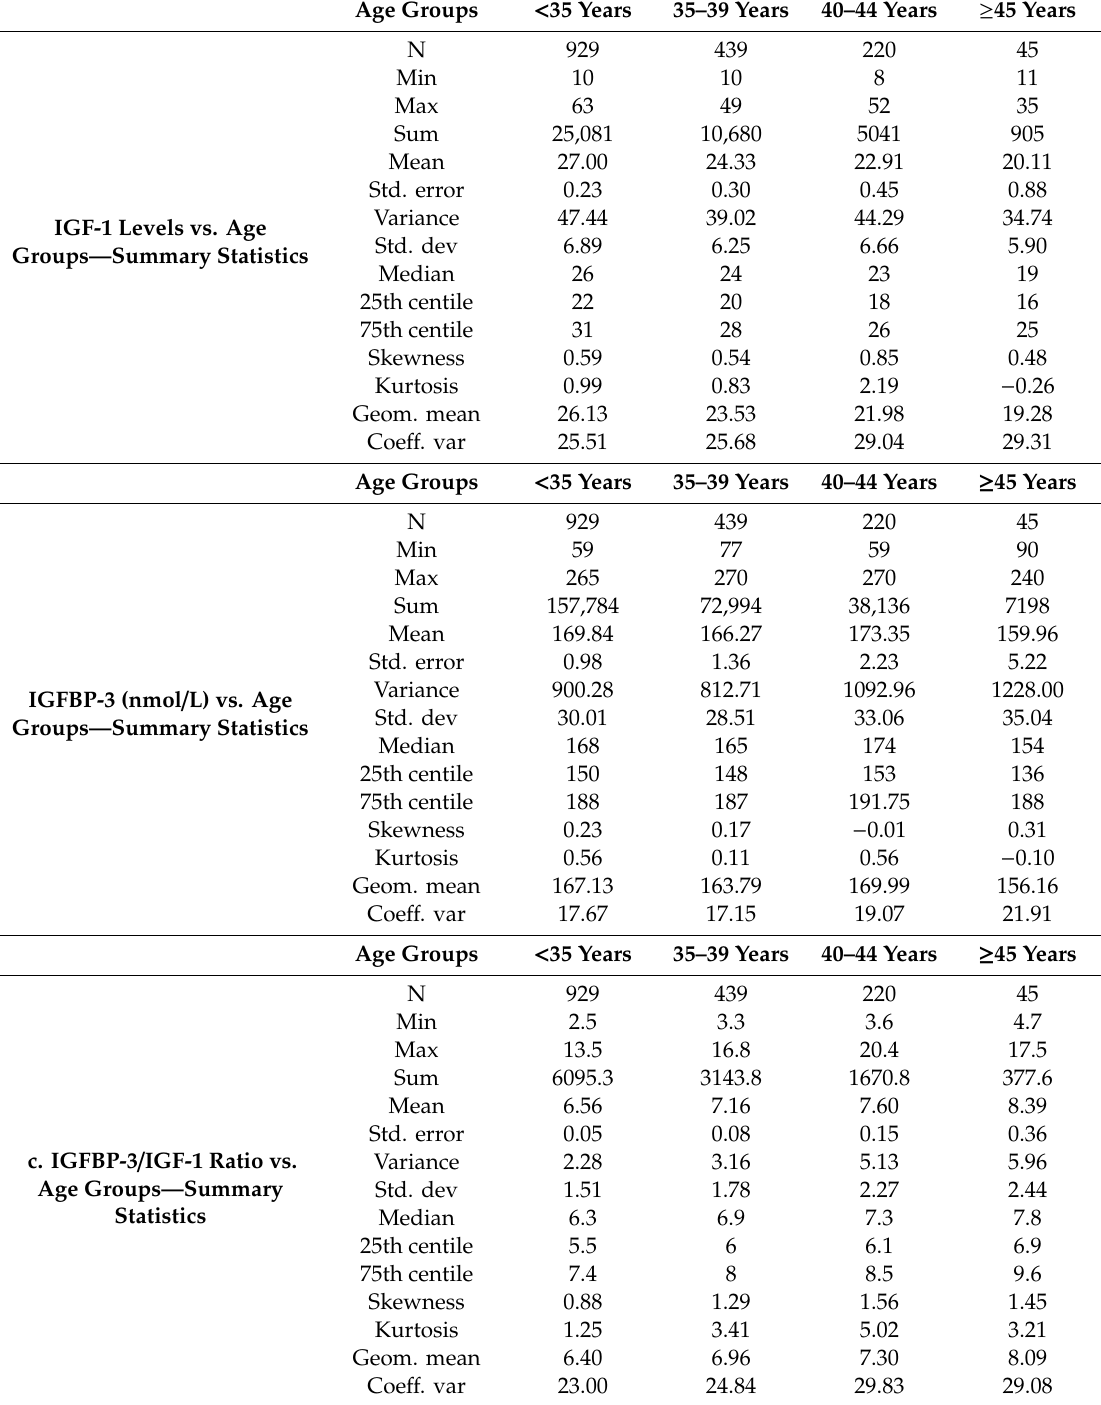
Table 2. Summary statistics are shown for the 1633 women stratified according to age groups shown in Figure 3. This shows the same statistical profile depicted in Table 1, now sub-categorized for the 4 age groups with respect to IGF-1 levels, IGFBP-3 levels and the IGFBP-3 / IGF-1